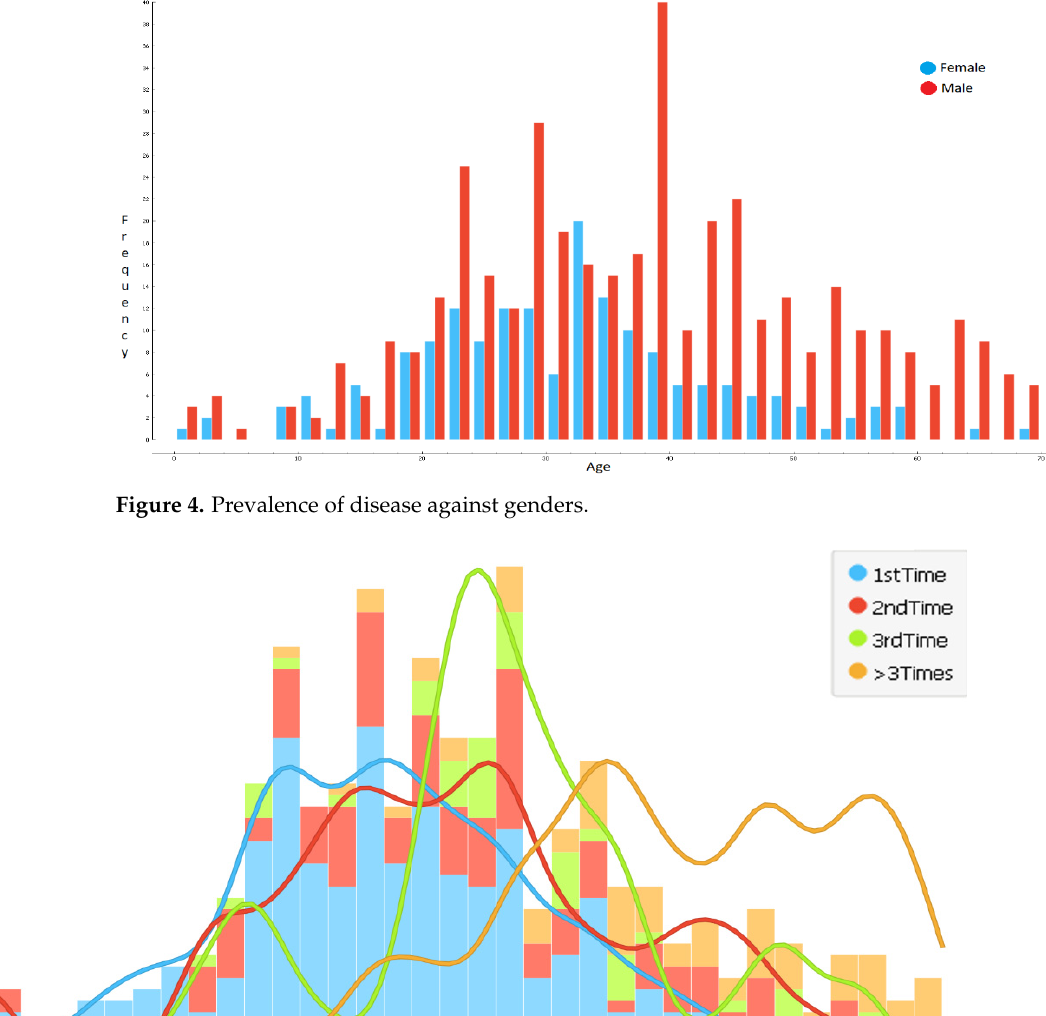
Table 9. Data classification on different types of drug prescriptions given to patients based on suf- fering counts. ↓ Diarrhea